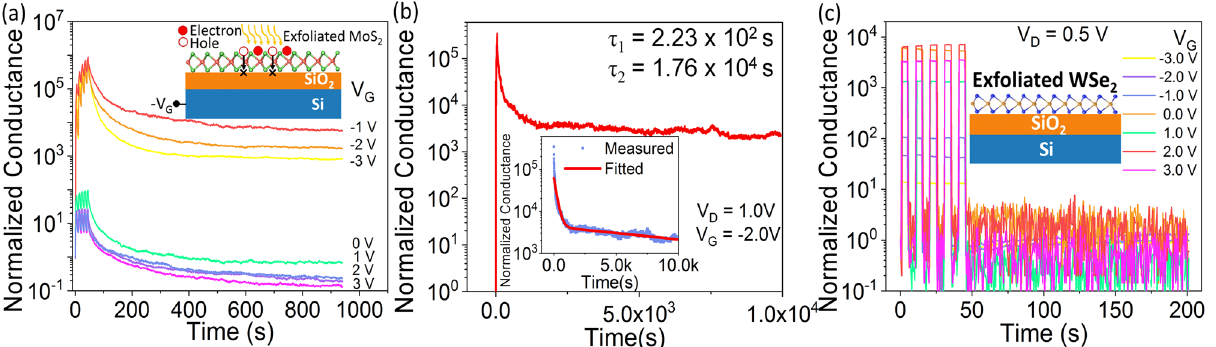
Figure 3. Exfoliated monolayer MoS 2 on SiO 2 gate: ( a ) Gate-tunable potentiation and conductance retention, ( b ) Retention for 10 4 s, after applying 5 light pulses. Inset shows retention curve fitted with an exponential decay function. ( c ) Potentiation and zero conductance retention of exfoliated WSe 2 on SiO 2 gate at different gate